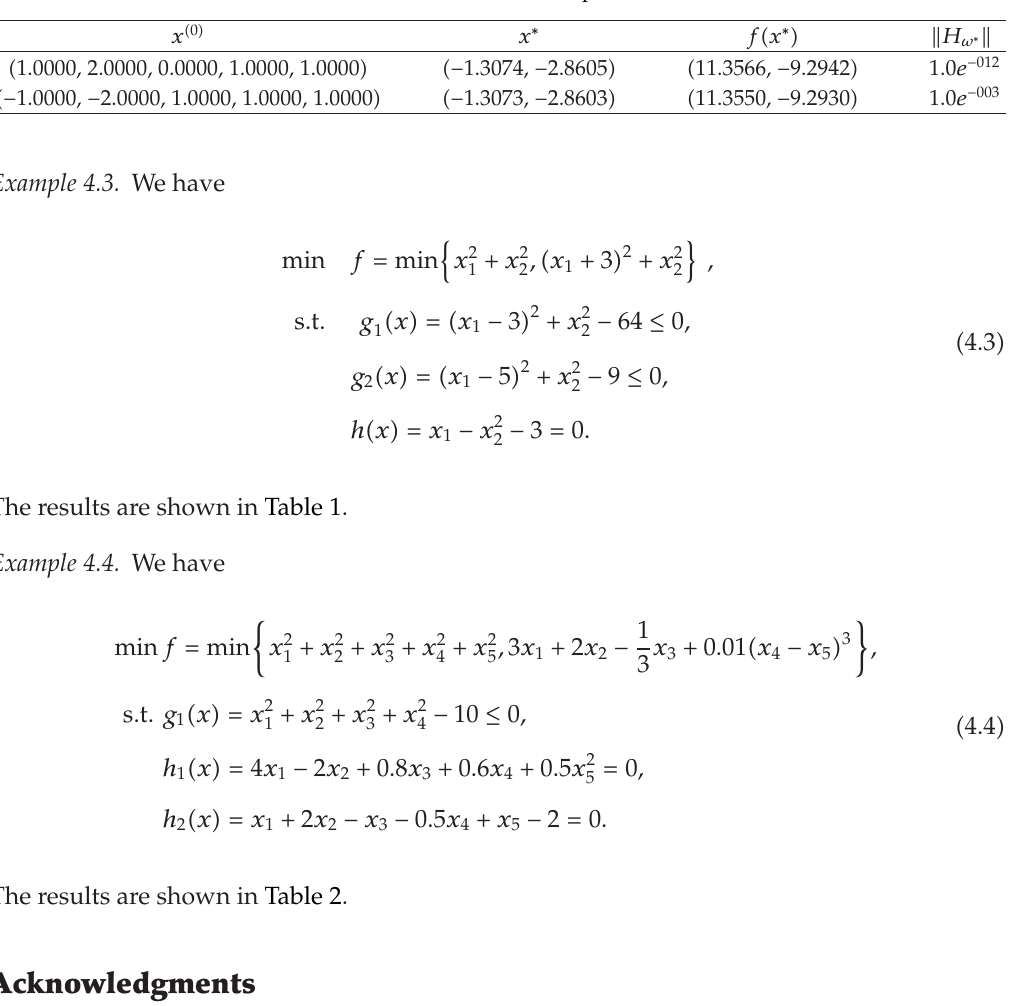
Table 2: Results of Example